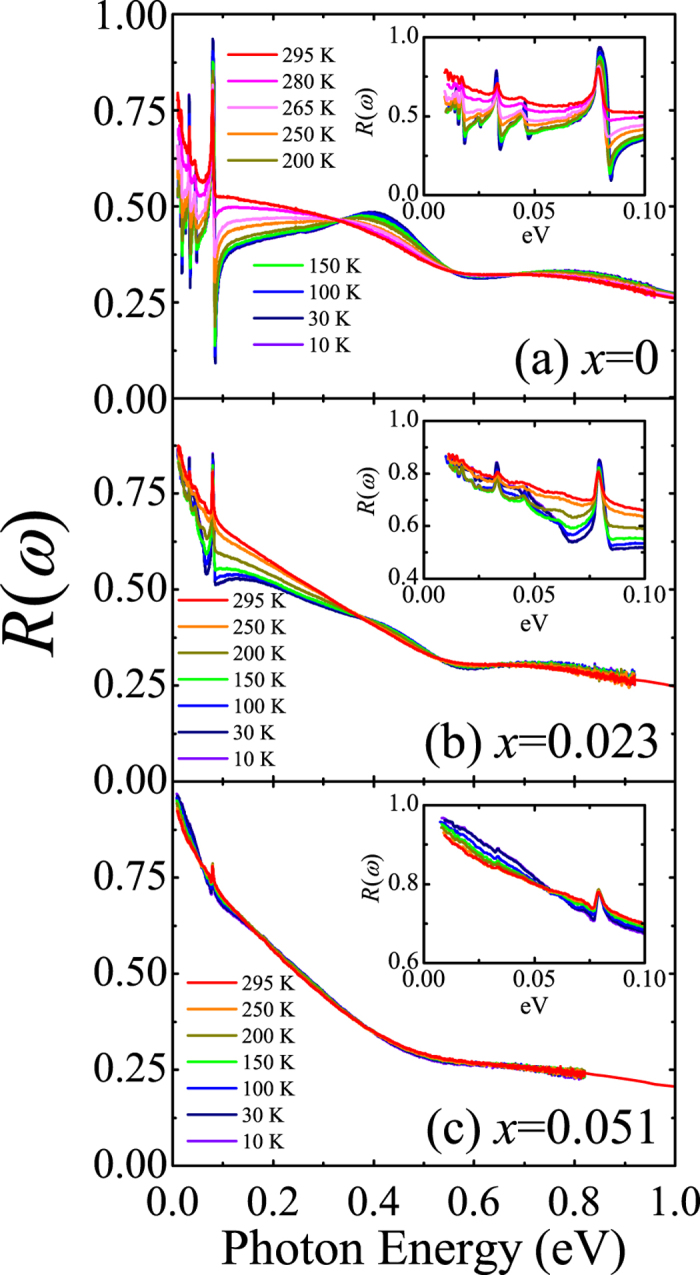
Temperature-dependent reflectivity spectra R(ω) of (a) Sr3Ir2O7 (x = 0), (b) (Sr0.977La0.023)3Ir2O7 (x = 0.023), and (c) (Sr0.949La0.051)3Ir2O7 (x = 0.051). Insets: R(ω) below 0.1 eV.